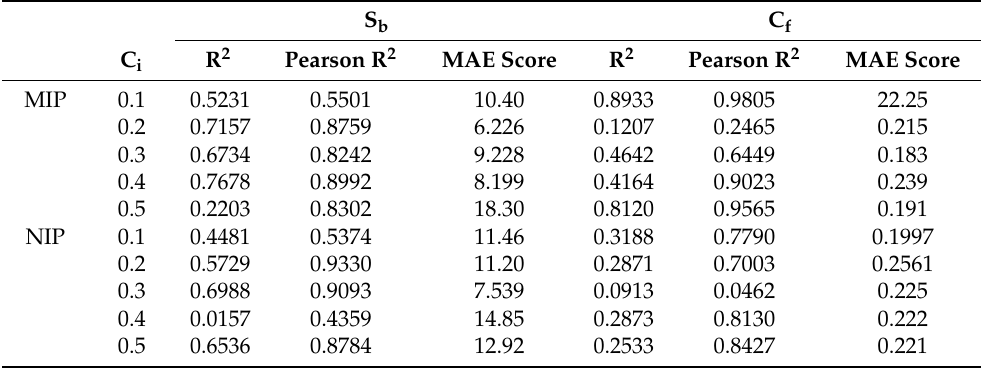
Table 4. Analysis of the error and correlation of the test datasets at a given C i value for the multitask regressor model. S b C